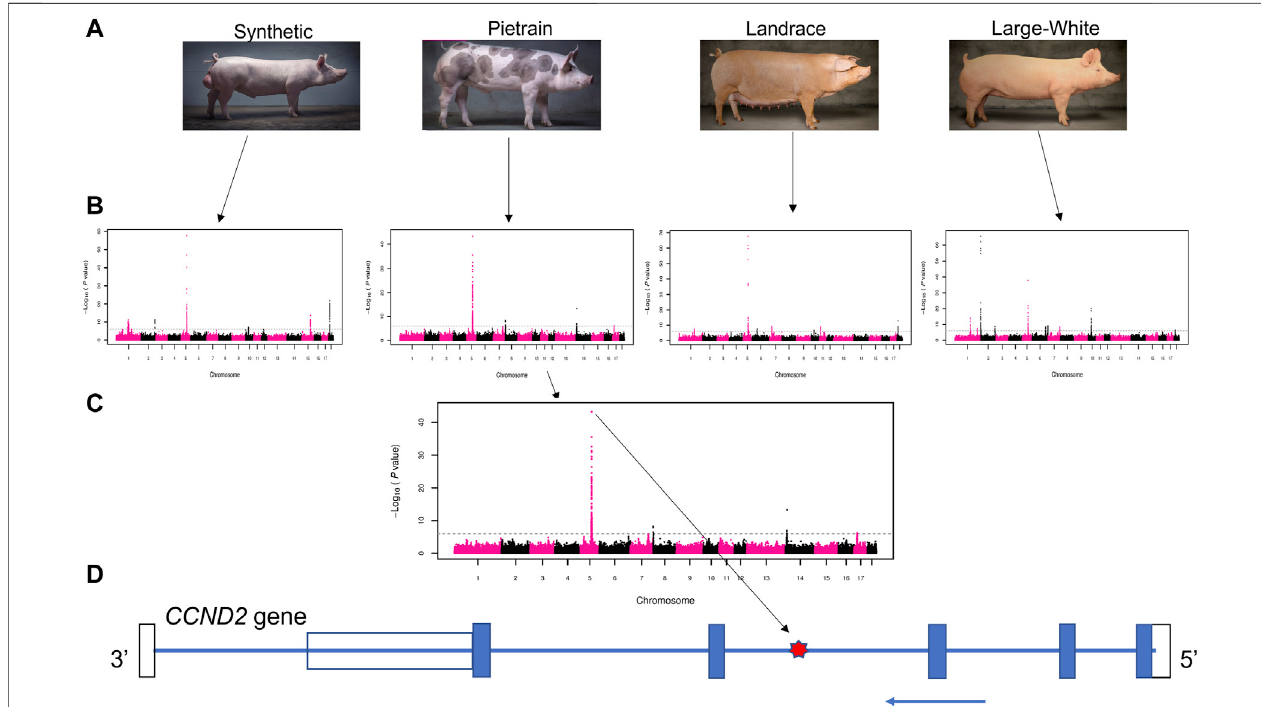
FIGURE 1 | Schematic representation of the GWAS results. (A) Four pig populations that presented the signi fi cant overlapping GWAS peaks on chromosome 5: Synthetic (Large-White based), Pietrain, Landrace and Large-White. (B) GWAS results for backfat in four populations. (C) Manhattan plot showing the most signi fi cant SNP (lead SNP - rs80985094) in the Pietrain population. (D) CCND2 gene model. The location of the lead SNP in the third intron is indicated with a red star. The blue arrow indicates the coding strand, blue boxes depict exons, the open bars the untranslated